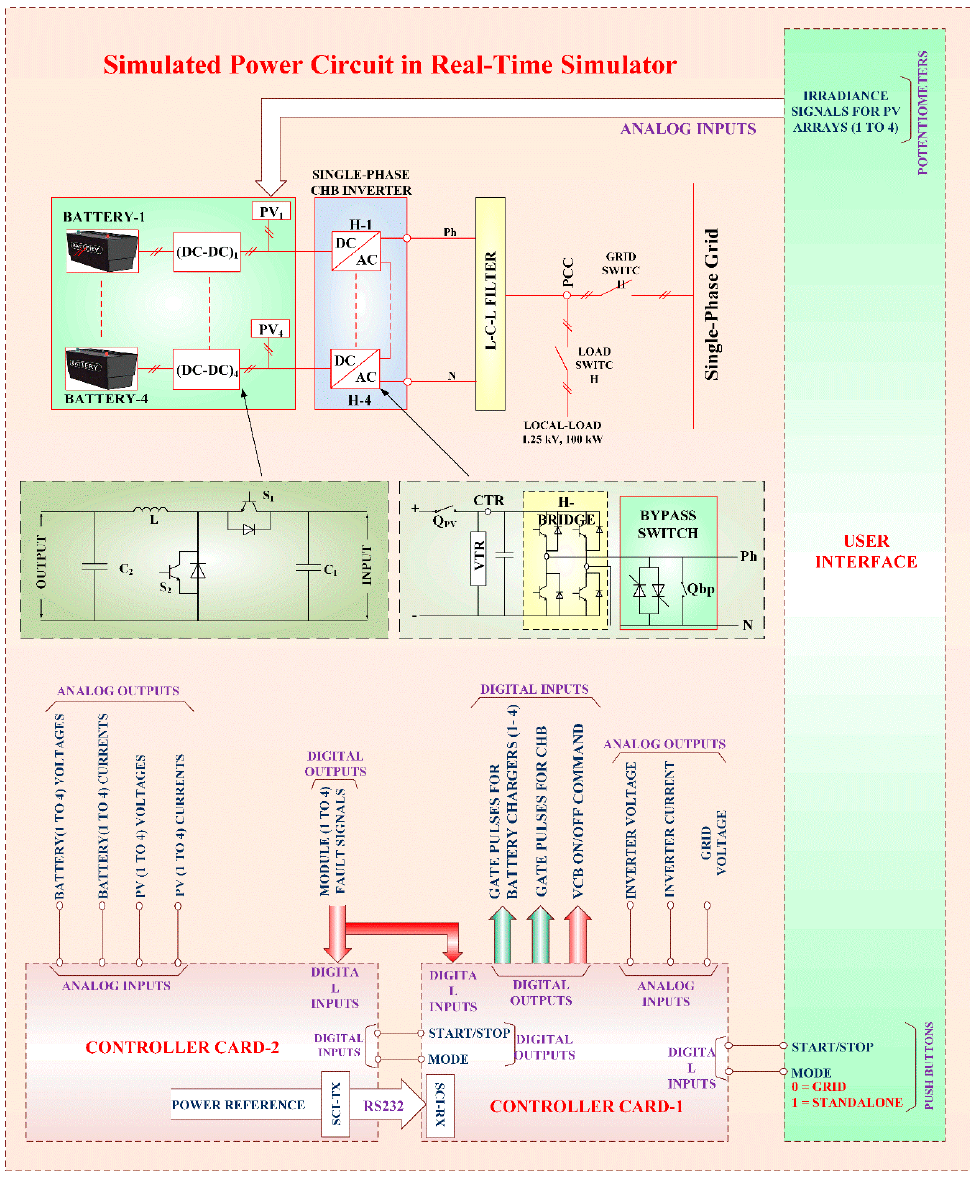
Figure 7. Block diagram of the controller-in-loop simulation setup.